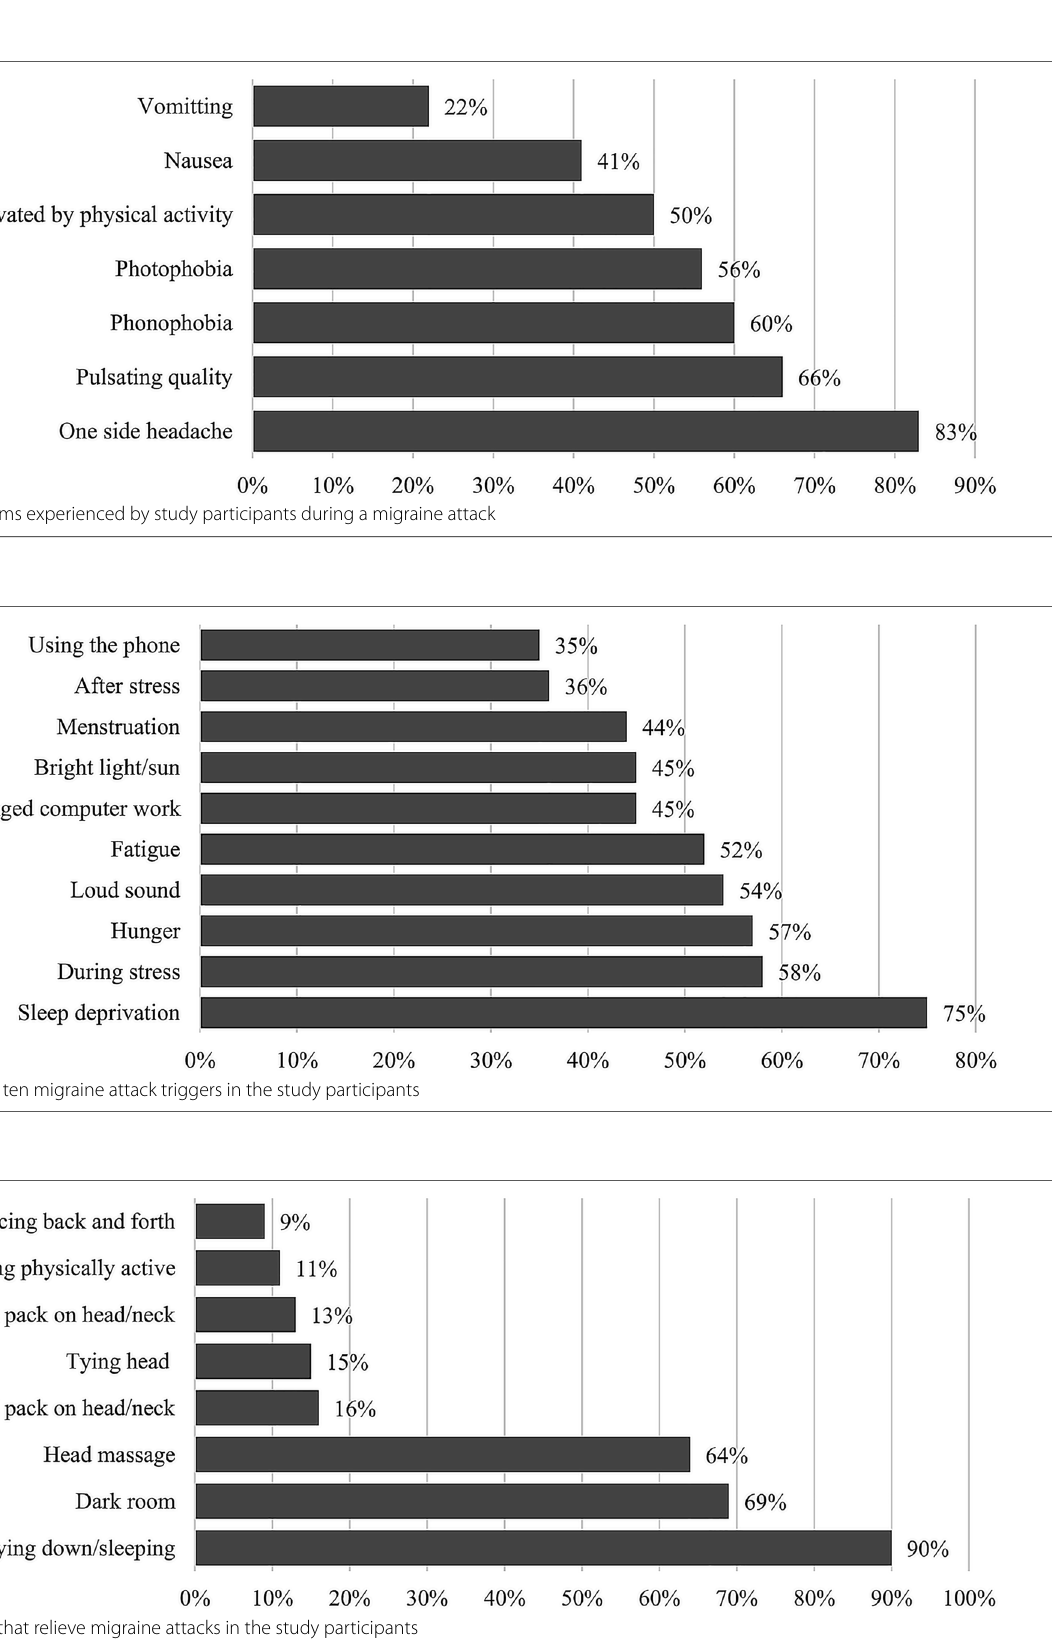
Fig. 4 Factors that relieve migraine attacks in the study